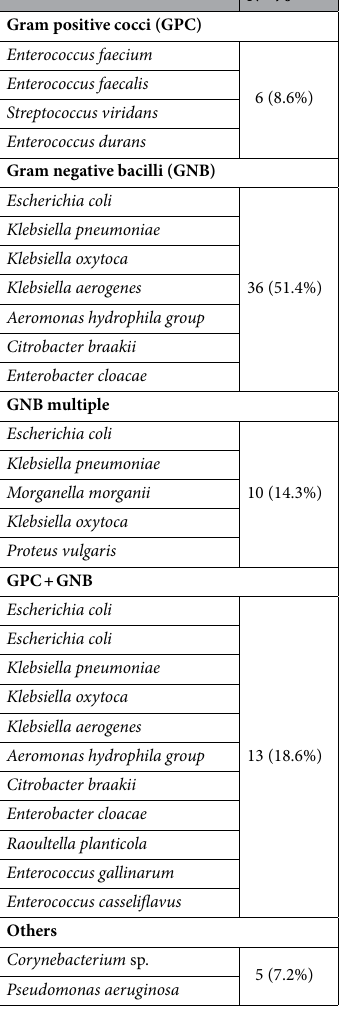
Table 1. Bacterial growth via percutaneous